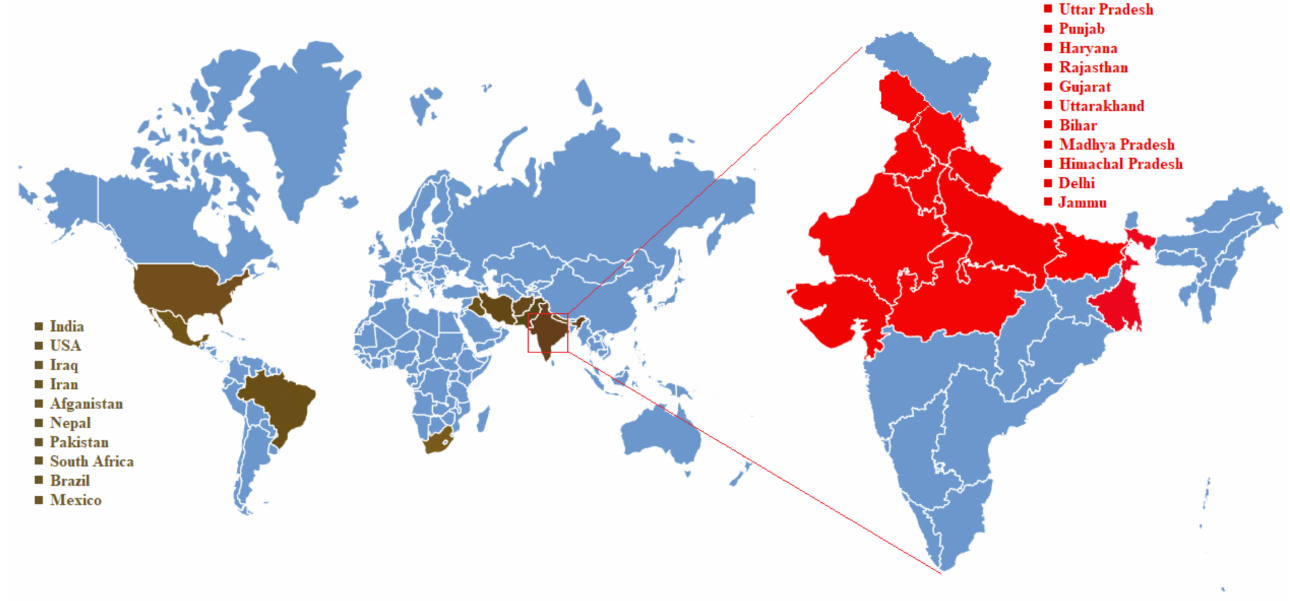
Figure 2. Countries with incidence of Karnal Bunt disease as reported till 2020. Distribution of infected countries (shown in brown) and states within India (shown in red). The KB positive states are indicated in red as per survey report of ICAR-IIWBR, Karnal,